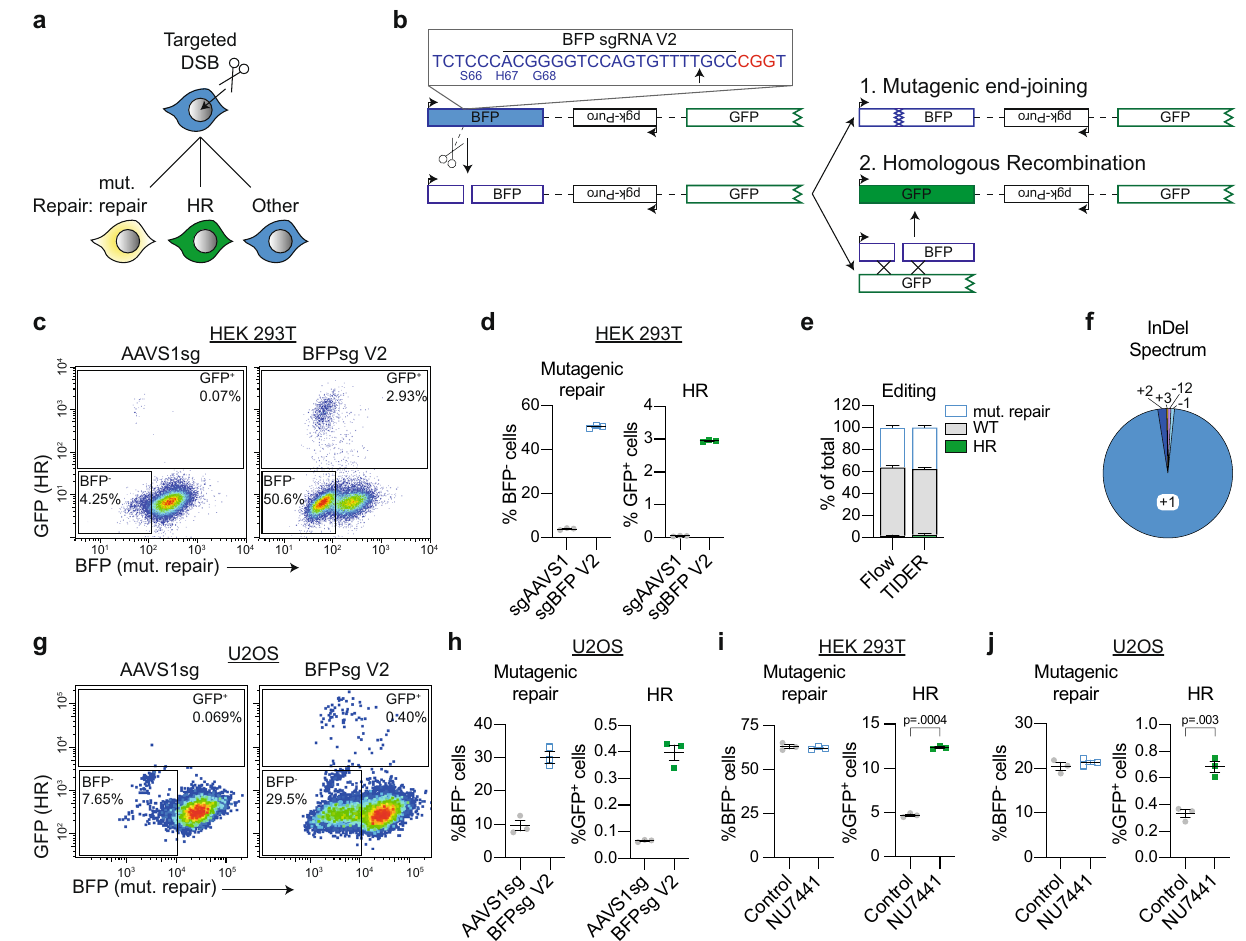
Fig. 2 | DSB-Spectrum_V2 is a reporter for both mutagenic repair and HR. a Cartoon depicting potential outcomes of a multi-pathway reporter cell-line designed to quantify DSB-repair by mutagenic end-joining and HR. b Diagramatic representation of the genomic DSB-repair reporter construct DSB-Spectrum_V2.ExpandedregionshowstheDNAsequencetargetedbyCas9. The sequence of the BFP cDNA is displayed in blue, the PAM sequence of the sgRNA target site is displayed in red. Arrow in the inset and scissors in the cartoonindicatetheCas9cutsite. c,d Flowcytometryplotsandquanti fi cation of mutagenicrepairandHRinDSB-Spectrum_V2cells( n = 3; mean ± SEM),asin Fig. 1c, d. e DSB-Spectrum_V2 cells were transfected with Cas9 and an sgRNA targeting either a control locus or BFP. At 48h after Cas9 transfection genome